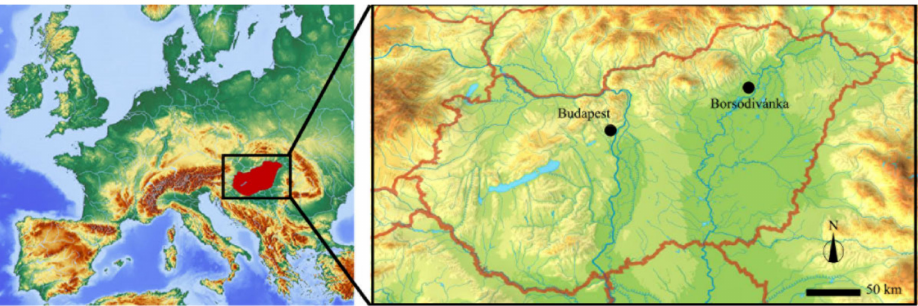
Figure 1. Borsodiv á nka location on the Borsod plain and the foothill zone of the Bükk mountains. Modified from www.pinterest.com (accessed on 2 February